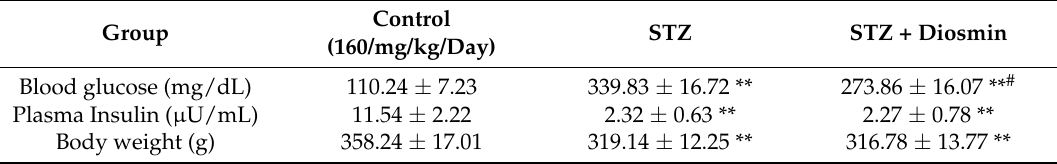
Table 1. Effects of diosmin on the changes in blood glucose and insulin levels, body weight, and food intake in rats. Group